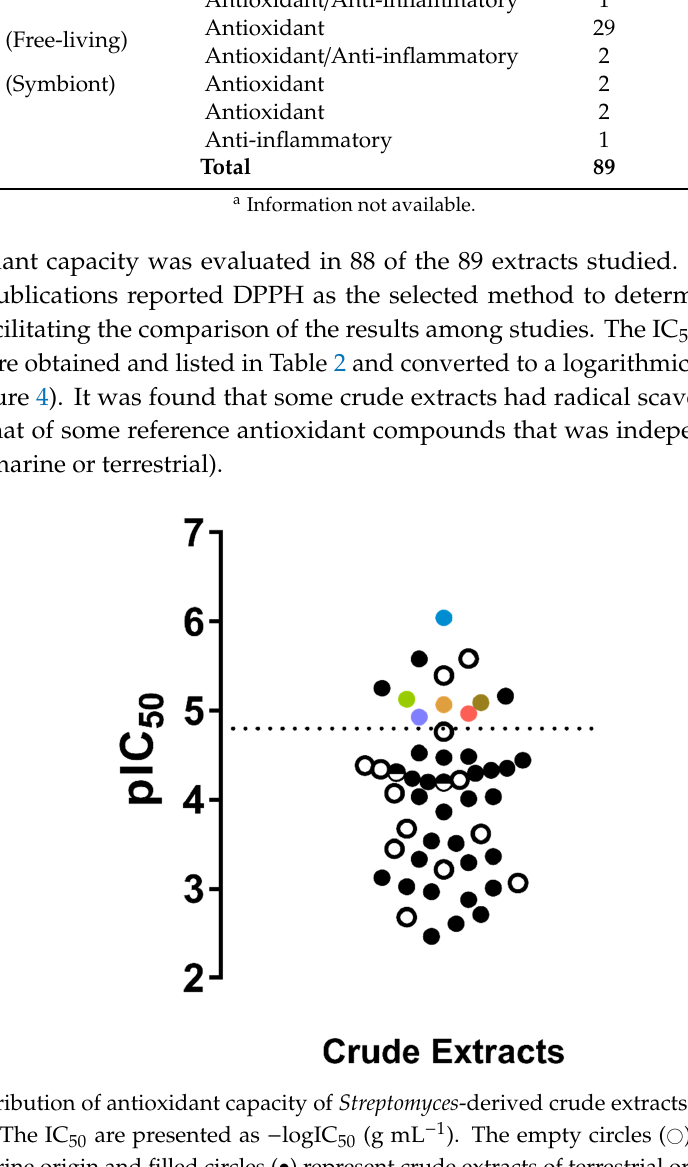
) represent crude (cid:35)